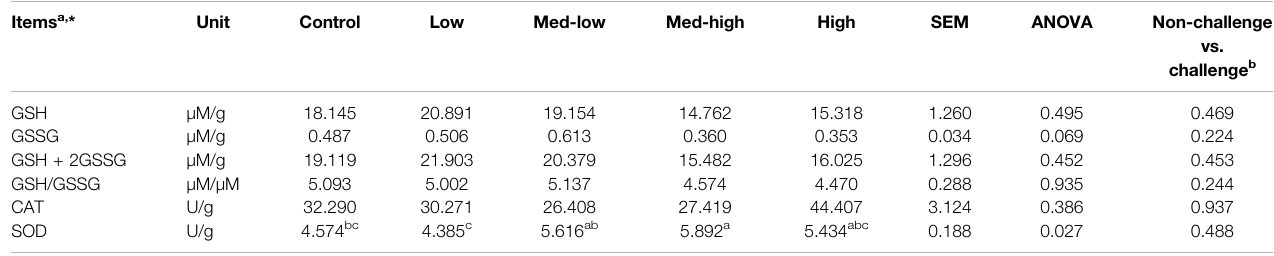
TABLE 6 | Superoxide dismutase activity (SOD, U/g bone marrow), catalase activity (CAT, U/g bone marrow), GSH (µM/g), GSSG (µM/g) and GSH/GSSG ratio (µM/µM) concentrations in bone marrow at six dpi.